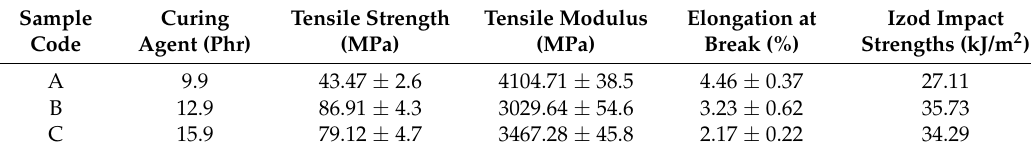
Table 4. Tensile strength, tensile modulus, and elongation at the break of various